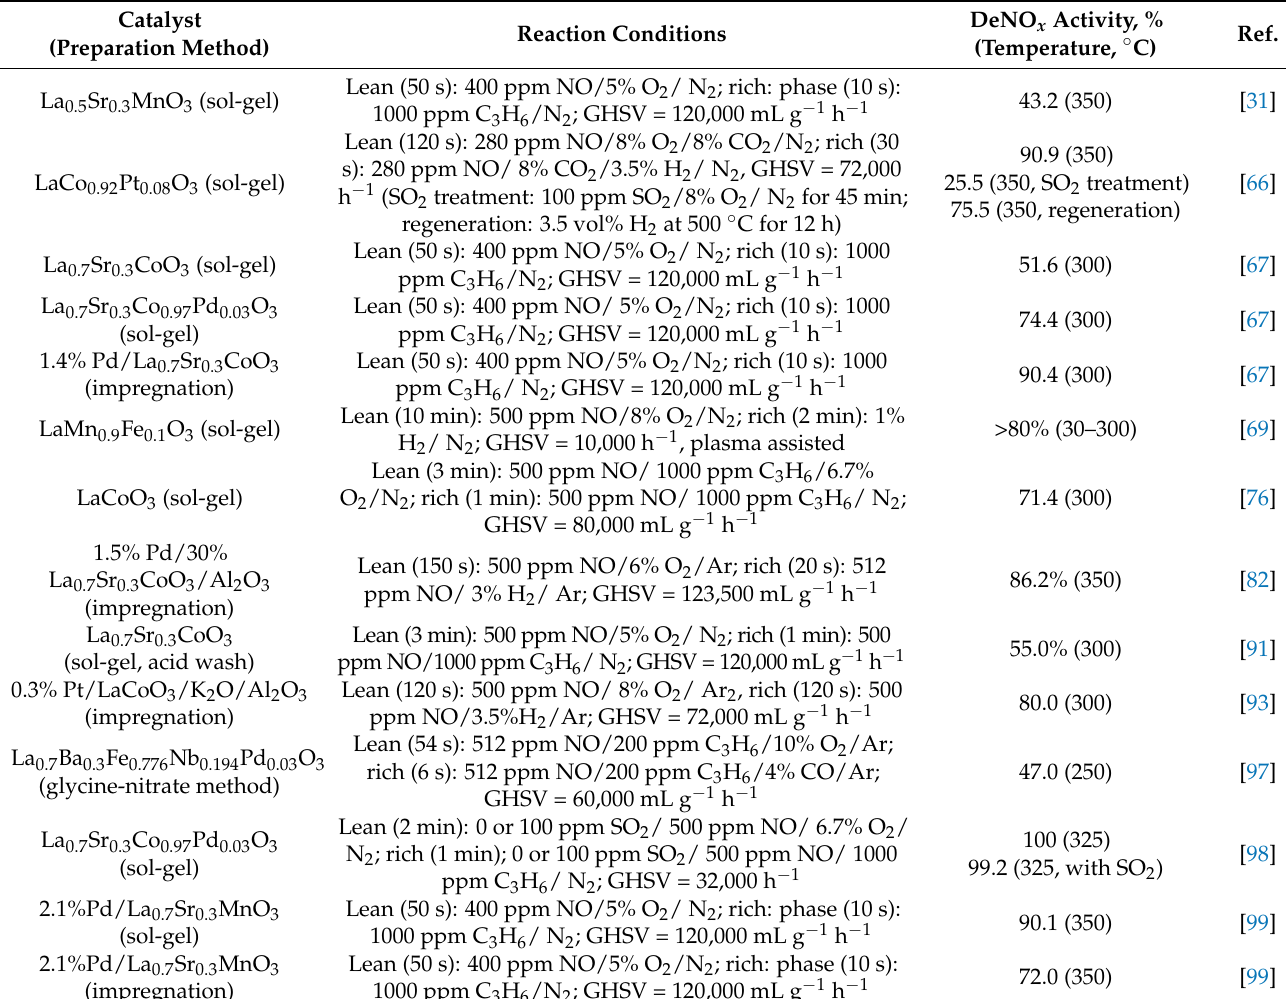
Figure 7. ( a ) De-NO x activity as a functions of reaction time at 350 ◦ C of La 0.7 Sr 0.3 MnO 3 ( (cid:78) ), Pd/La 0.7 Sr 0.3 MnO 3 -sol-gel ( (cid:4) ), Pd/La 0.7 Sr 0.3 MnO 3 -impregnation ( • ), and pretreated Pd/La 0.7 Sr 0.3 MnO 3 –ol-gel ( (cid:72) ); and ( b ) illustrative profile of in situ activation of Pd/La 0.7 Sr 0.3 MnO 3 - sol-gel catalyst. Adapted with permission from [99]. Copyright 2021, Elsevier. Table 2. Review of the reaction conditions and DeNO x activity of the La-based